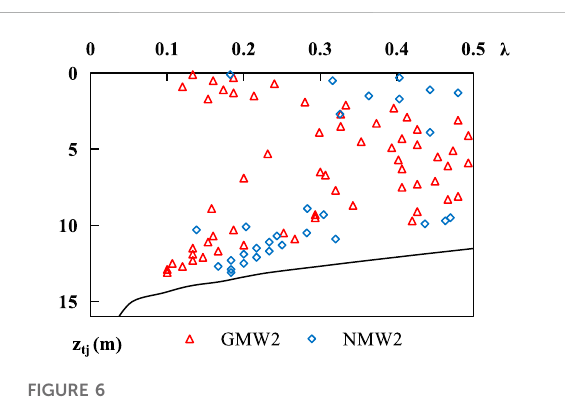
FIGURE 5 Curve diagram of measured vertical concentration change of chloride ions (the red dotted line is traceable historical contamination curve, and the red solid line is measured concentration change trend after surface disturbance).